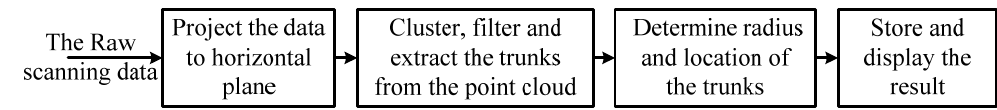
Figure 2. The data analysis flow.